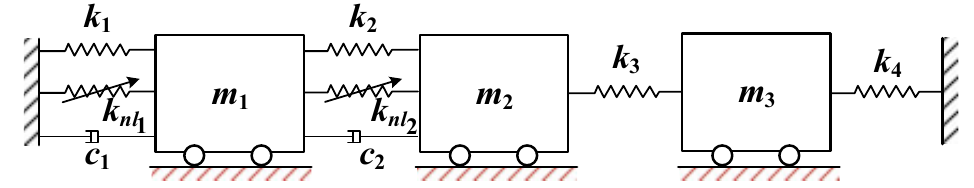
Figure 5. Simplified MDOF model with a cubic nonlinear spring.